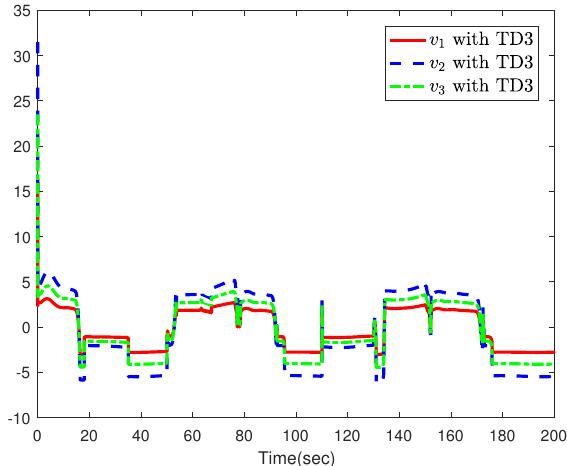
Figure 15. Control effect of System (3) without stochastic noise under